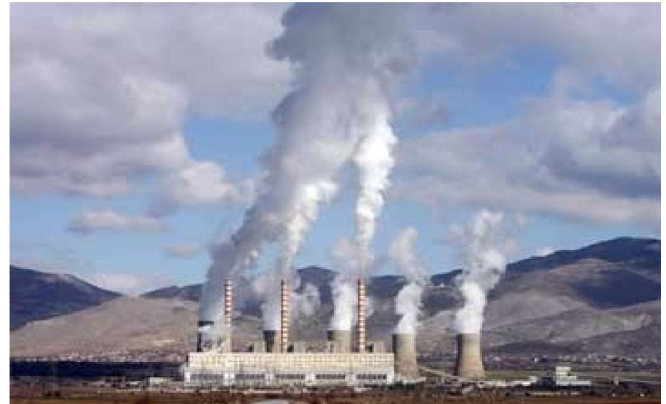
Figure 1. Photo of a real TPP (Kozani, Greece)